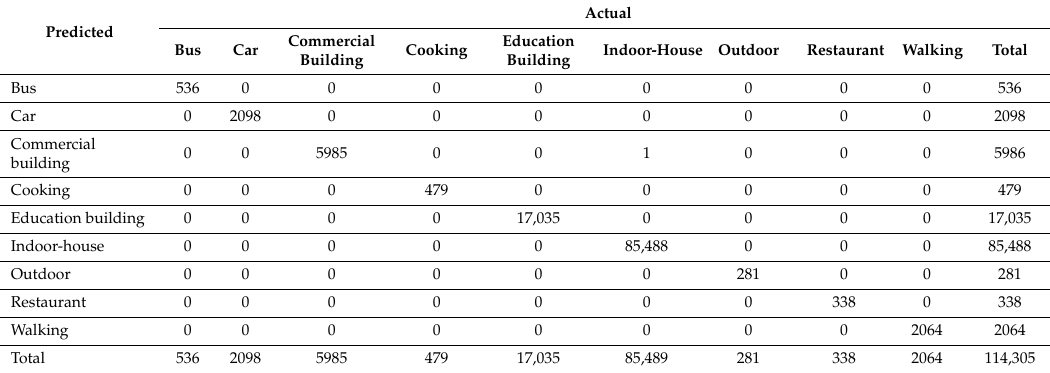
Table 4. Confusion table for training data simulation using statistical dataset.